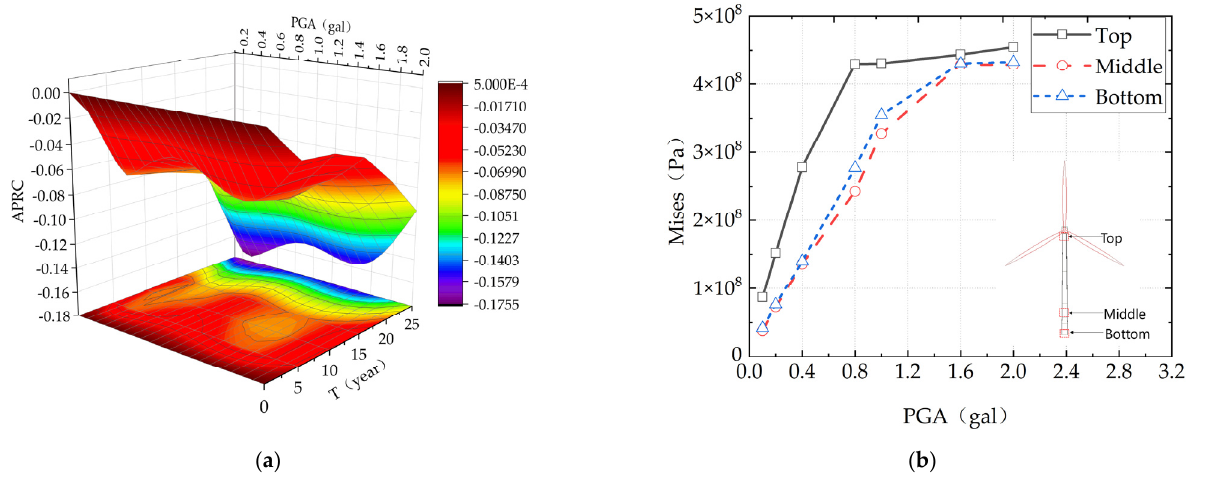
Figure 14. The Nihonkai-Chubu earthquake: ( a ) structural APRC value; ( b ) maximum Mises stress.